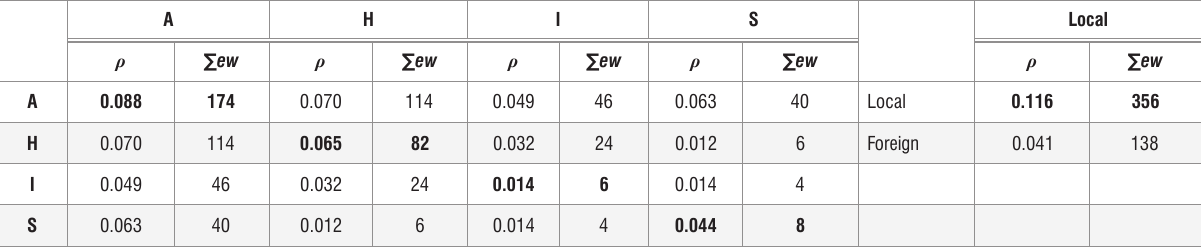
Quantitative measures of within-group (bold text; intra-sectoral or local) and between-group (normal text; cross-sectoral or international)